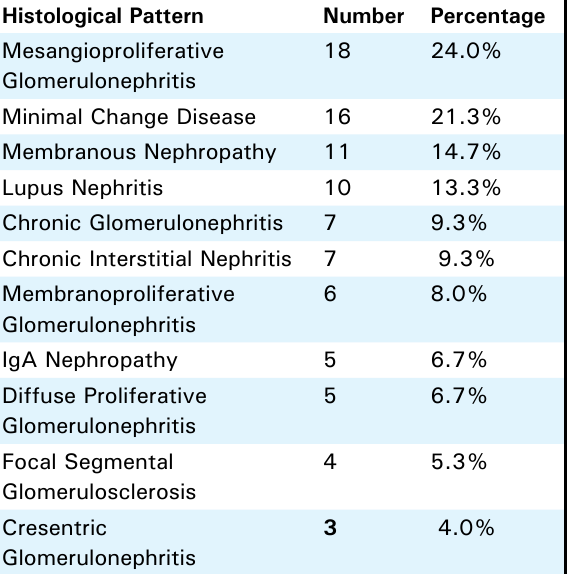
table 4. Histological pattern.